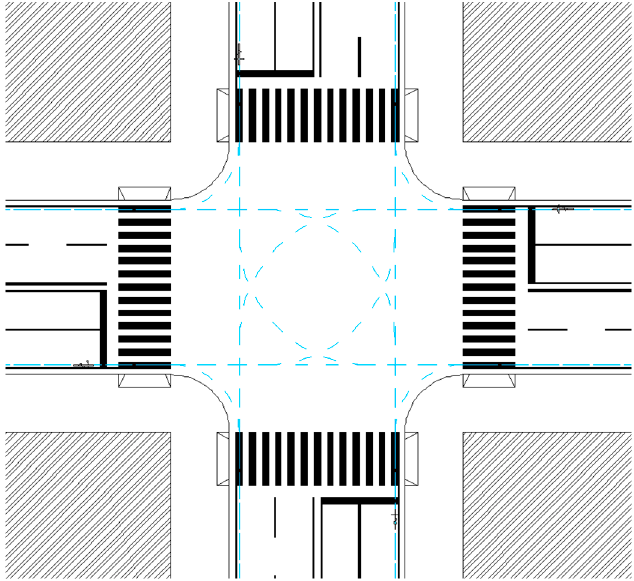
Figure 3. Trajectory diagram of bikes in a four-arm junction.